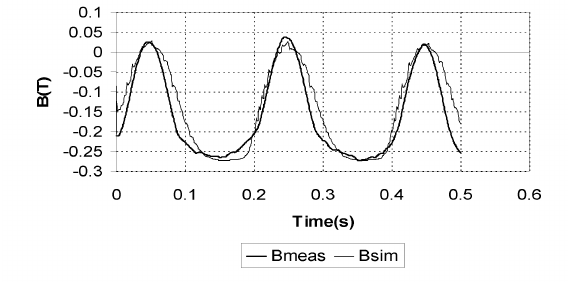
Figure 18: Flux Density of the FCL with corrected phase